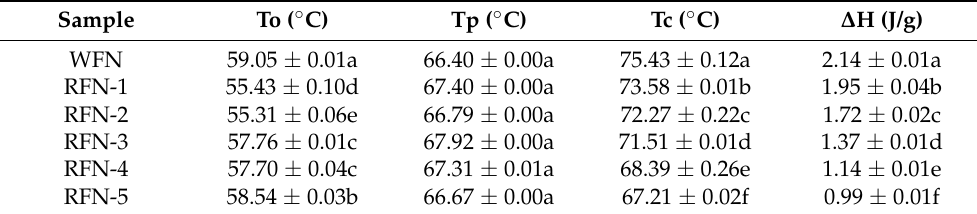
Table 6. Effect of highland barley flour with different particle sizes on the thermal properties of noodles.